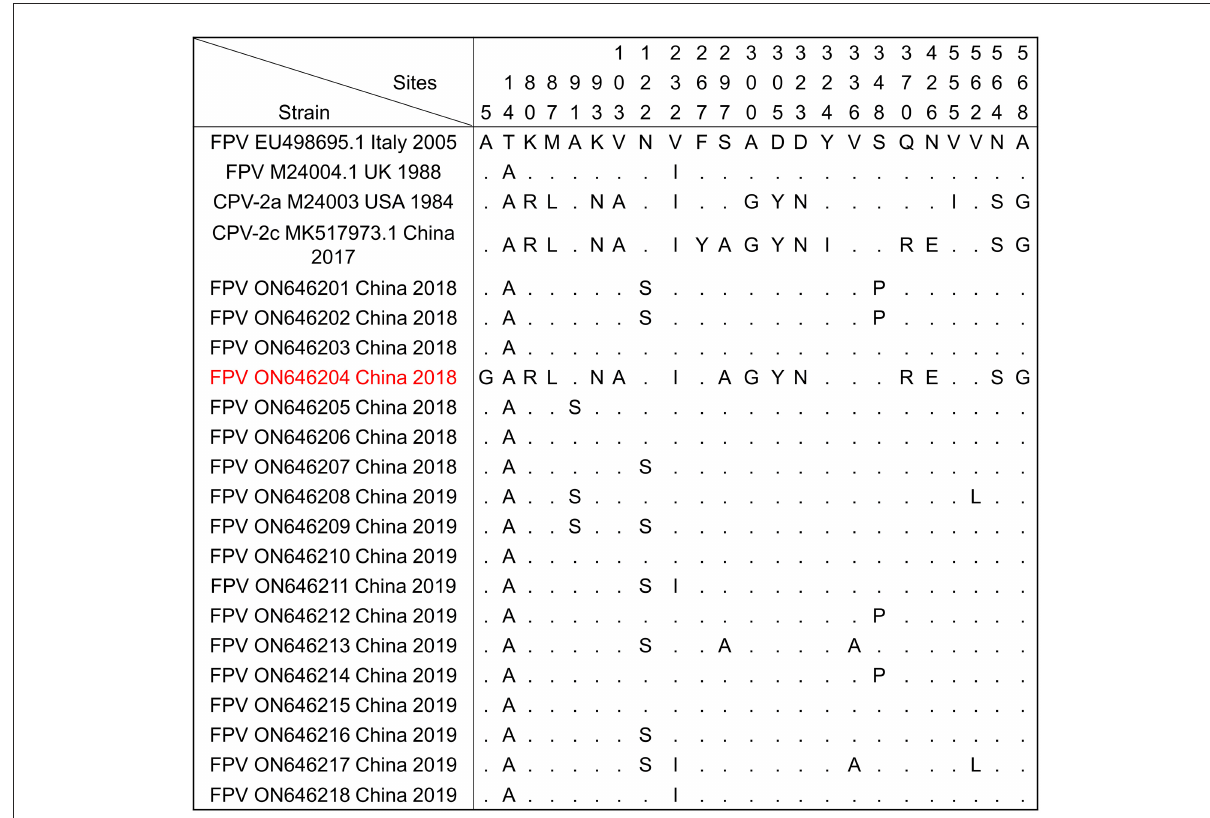
FIGURE2 Amino acid mutations in the VP2 protein of FPV and CPVs. The amino acid mutation sites of the VP2 protein of 18 cat-derived parvoviruses obtained in this study were analyzed by MEGA 5.1 software. FPV (EU498695.1 and M24004.1), CPV-2a (M24004), and CPV-2c (MK517973.1) were used as reference